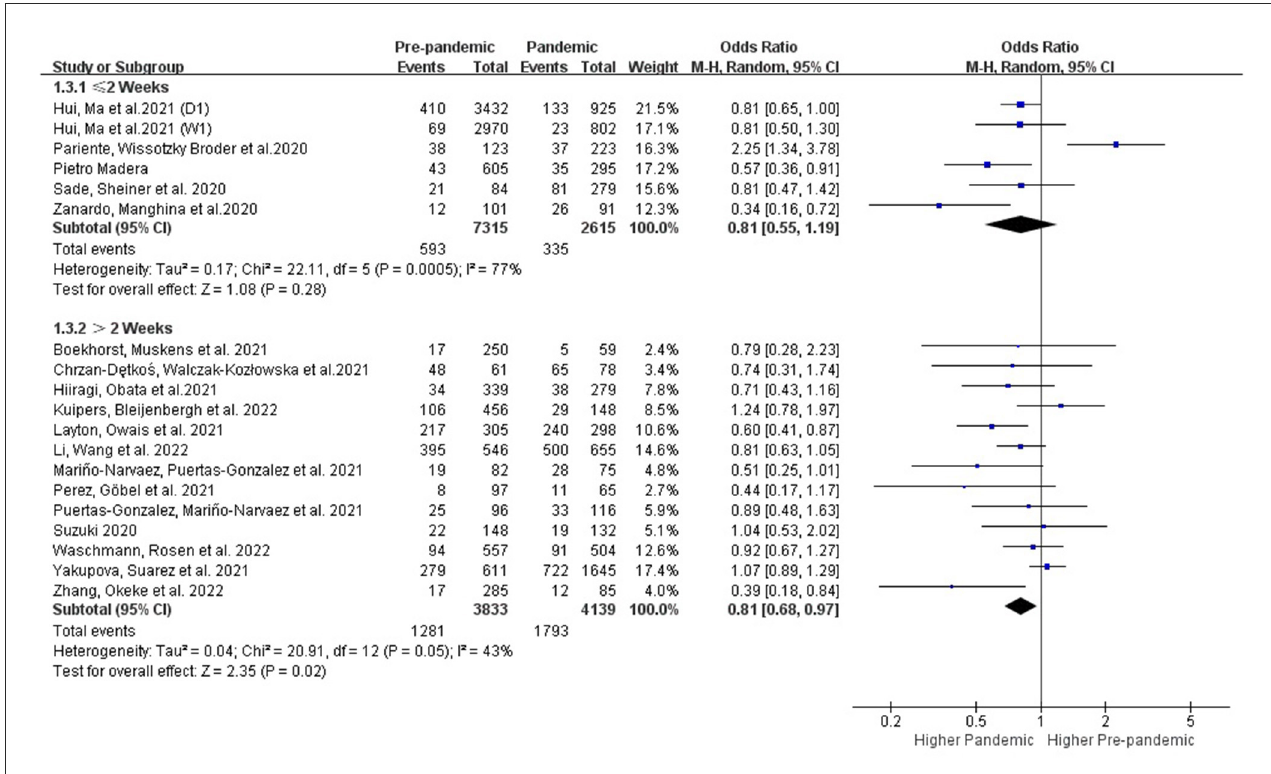
FIGURE4 Subgroup analysis comparing the prevalence of PPDS before and during the COVID-19 pandemic according to postpartum